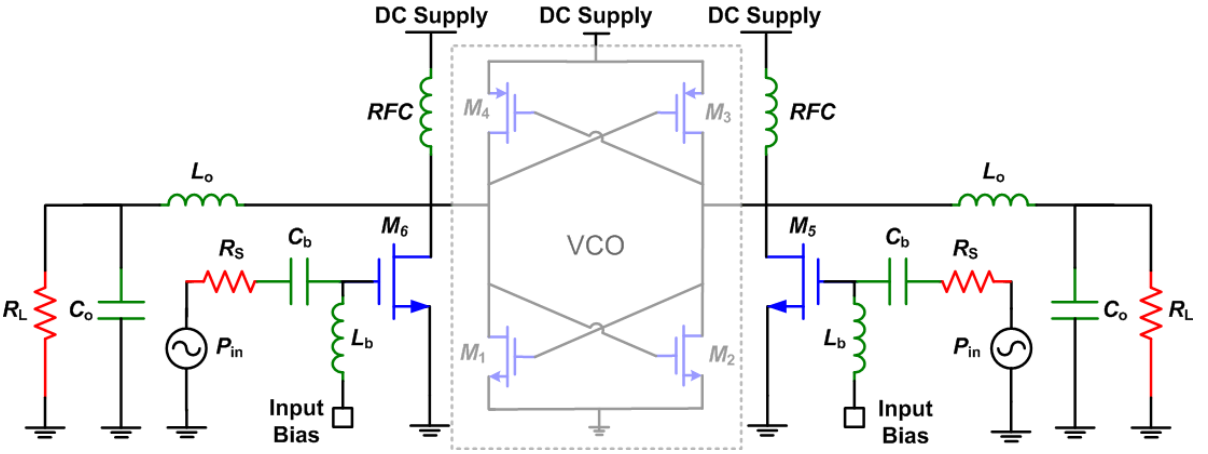
Figure 14. Differential class-E power amplifier with mode-locking, reproduced from